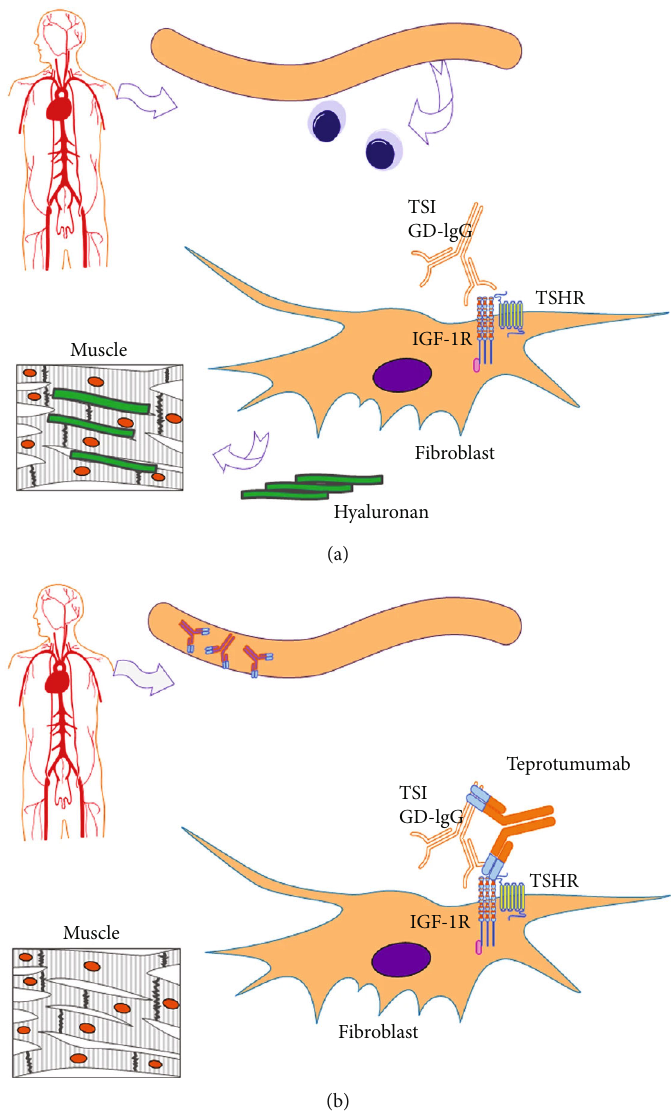
Figure 2: (a) Hyaluronan is produced by the binding of pathogenic autoantibodies and receptors of orbital fi broblasts and causes symptoms of thyroid eye diseases. (b) Teprotumumab blocks the binding of pathogenic autoantibodies and its receptor on orbital fi broblasts. Reproduced with permission from Douglas